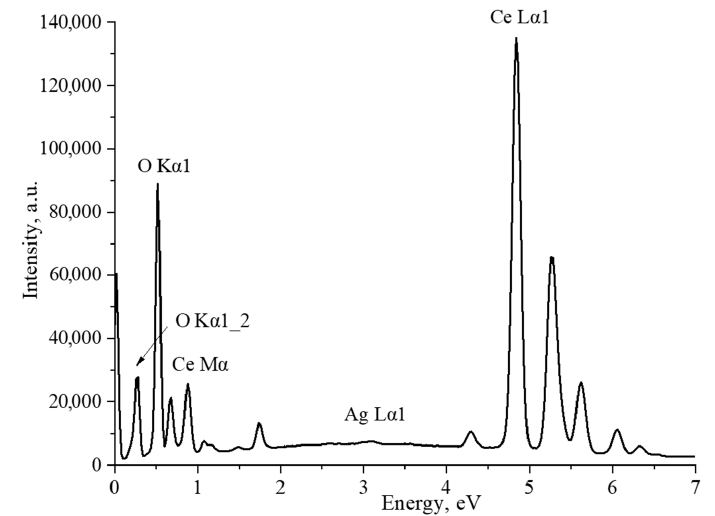
Figure 5. EDX spectrum of the CeO 2 -Ag4 sample.